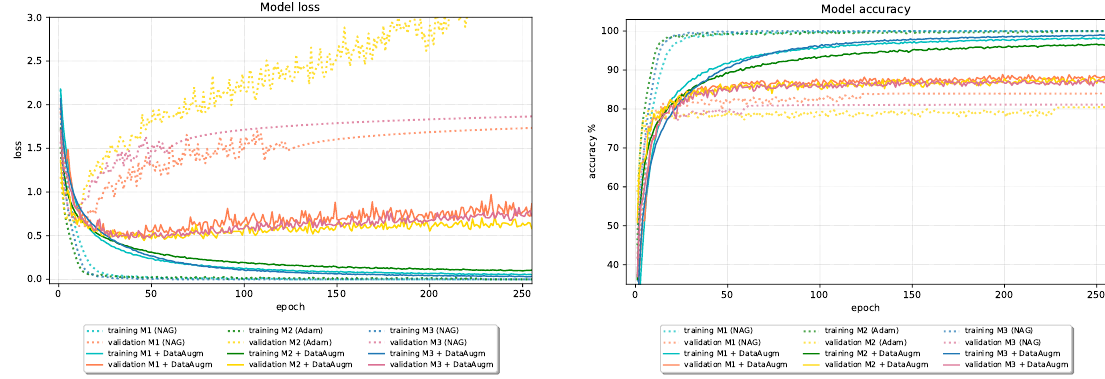
Figure 17. The effect of Data Augmentation on baseline models trained on CIFAR-10